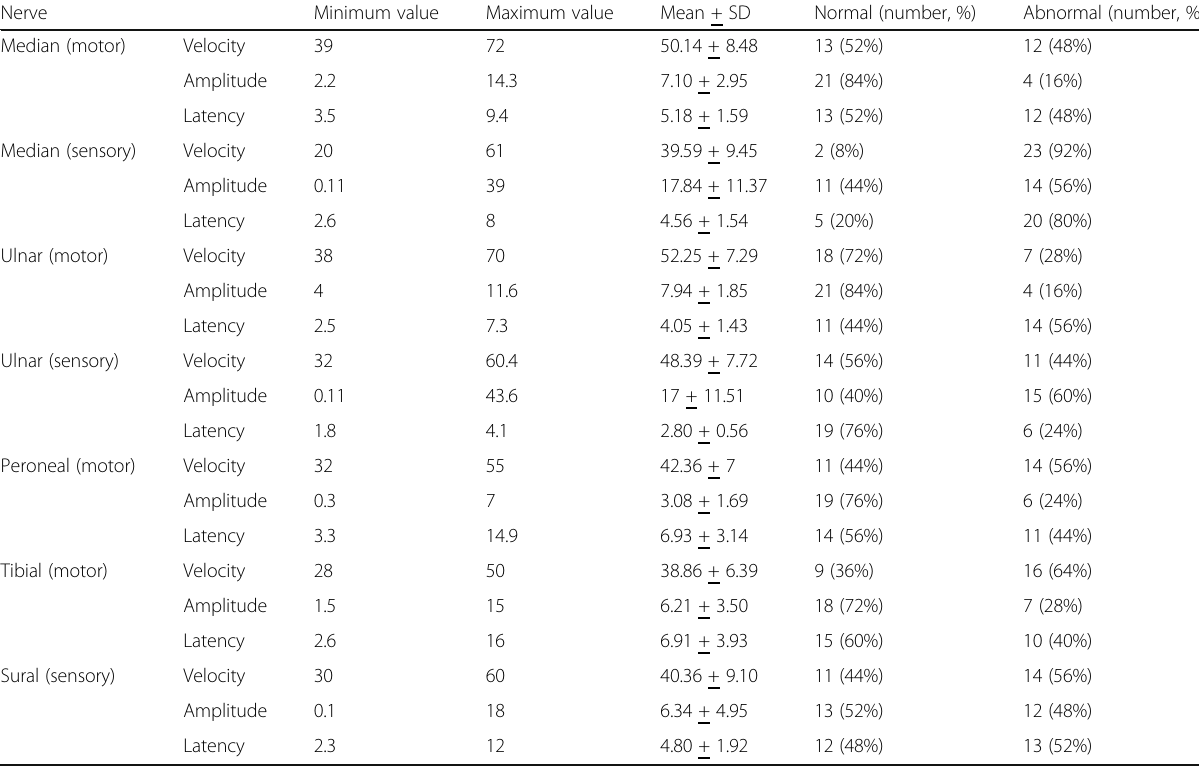
Table 3 Results of nerve conduction